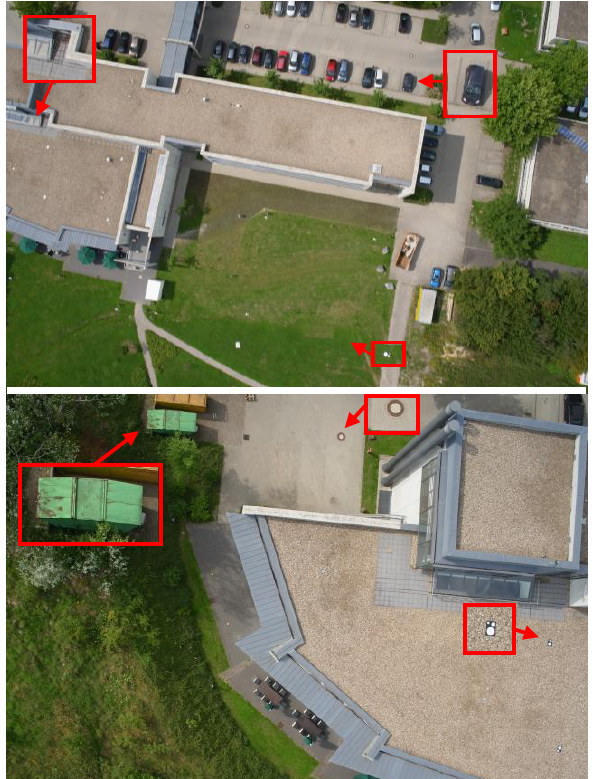
Figure 7. Aerial images (camera: Ricoh GXR, f=18mm) Top: 1/870sec, F/5.6, ISO 200, altitude: 100m Bottom 1/1410sec, F/4.0, ISO200, altitude: